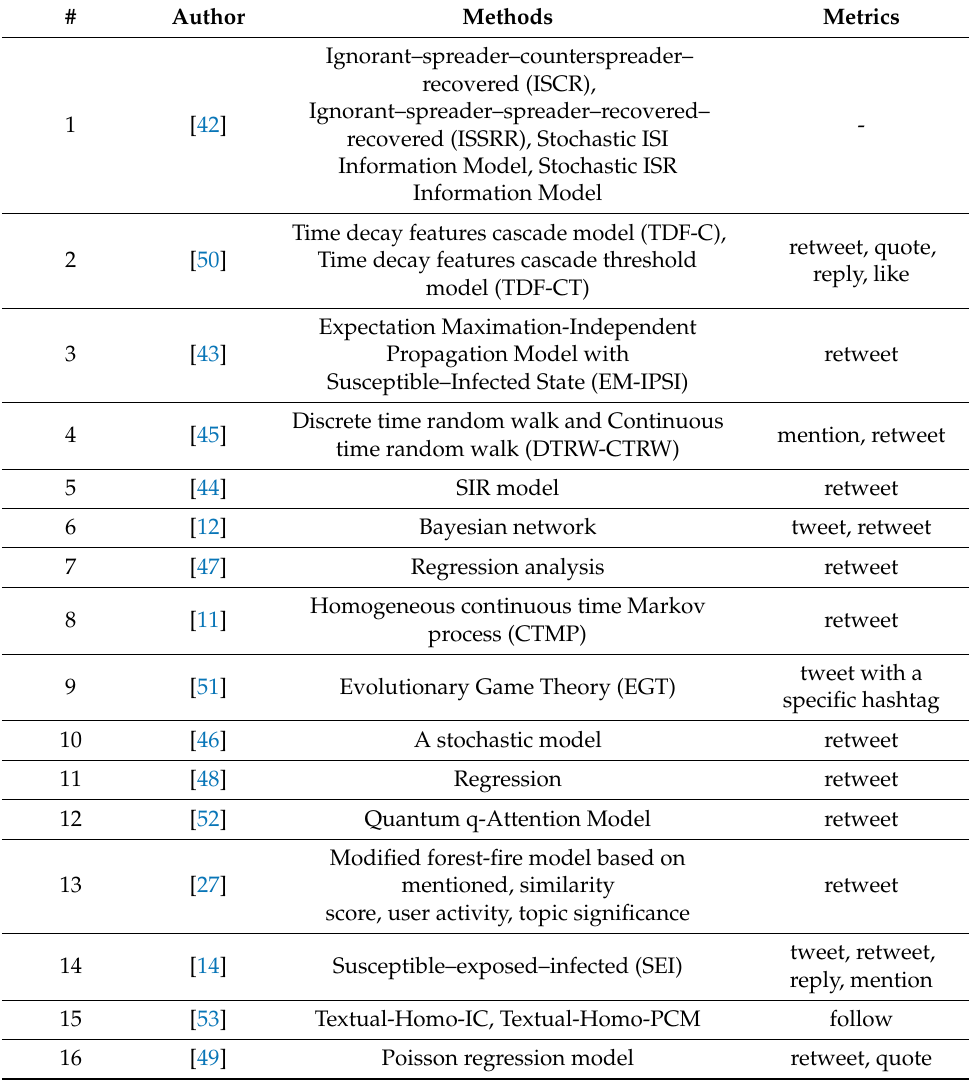
Table 4. Studies of the information diffusion model on